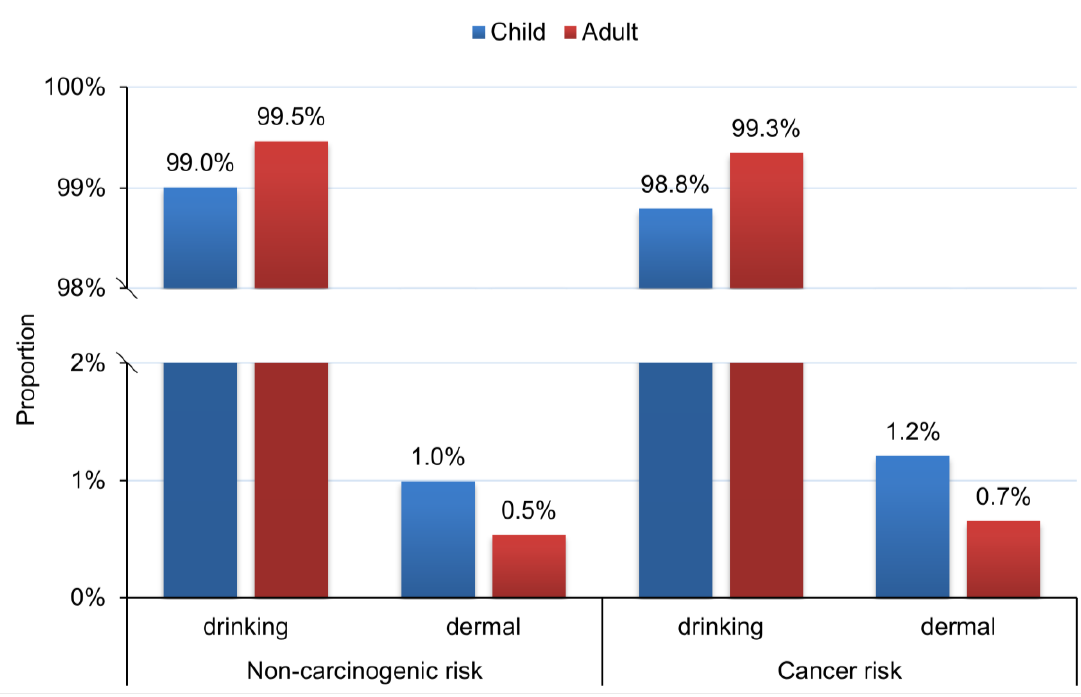
Figure 5. Risk proportion of different risk pathways.